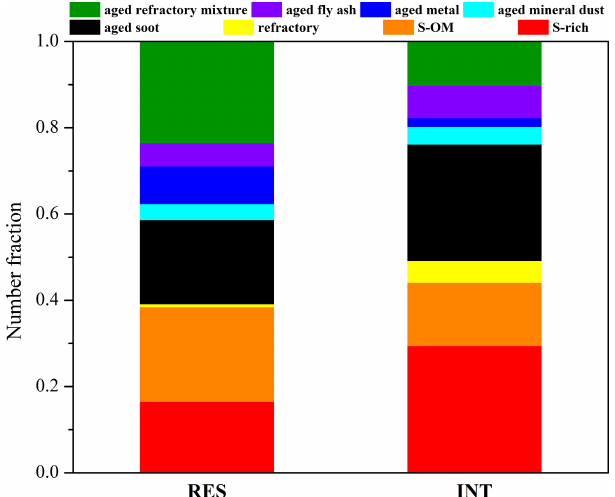
Figure 2. Number fractions of different particle types in the RES and INT of cloud event nos. 2 and 3 measured by TEM/EDS.